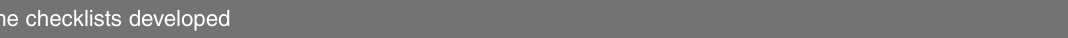
CHl1. Open spaces and